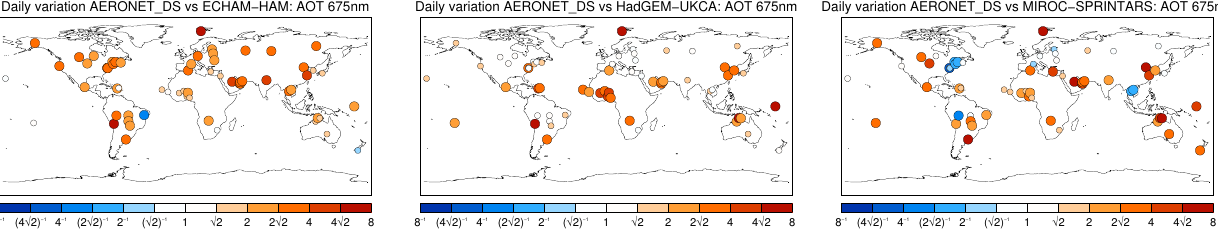
Figure 6. Median ratio of daily difference in maximum and minimum AOT δ o /δ m , either observed or modelled, for all AERONET sites. Smaller circles indicate sites where 0 . 5 ≤ median δ o /δ m ≤ 2. Only sites with more than two observations per day for at least 24days during 3 or more separate months were used.